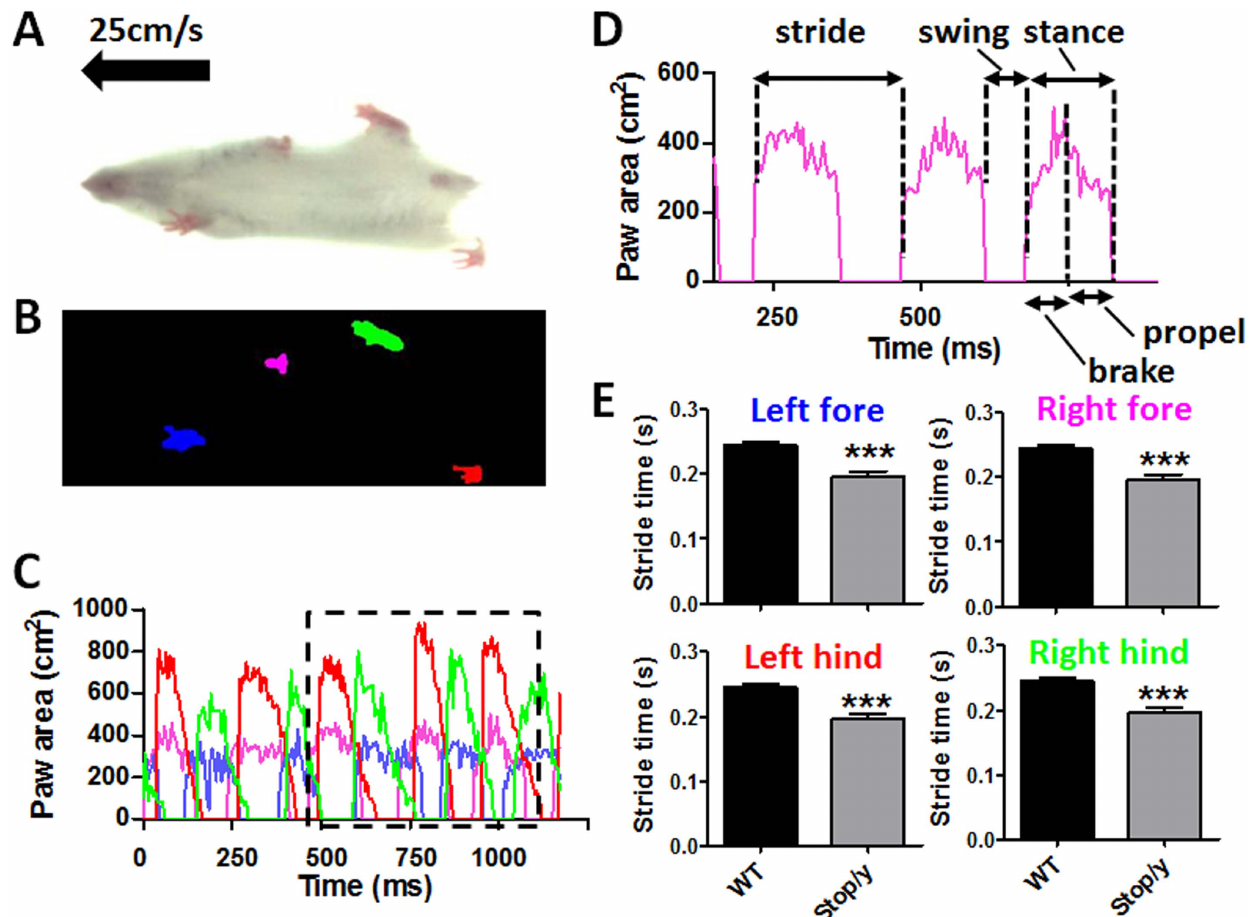
Figure 1. Treadmill-based measurement of gait properties in Mecp2 stop/y mice. (A) Video still image showing mouse walking on transparent treadmill (viewed from below) at 25 cm/s. (B) Placement of each paw is detected from the video illustrated in (A). (C) Graph of paw area in contact with the treadmill surface for each paw over time (one session, one animal); the area outlined in black has been replotted in (D). (D) Excerpt from (C) showing calculated paw area in contact with treadmill surface over time for a representative single paw (right fore; pink in B and C), from which multiple stride indices can be obtained (labeled). (E) Column plots showing stride time measures (mean + / 2 SEM) for each limb in 8 week old wild- type (WT) and Mecp2 stop/y mice (*** p , 0.001 relative to WT; t -test, n=5 per